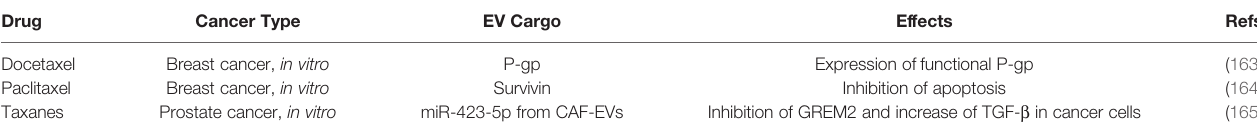
TABLE 4 | Resistance to taxanes mediated by